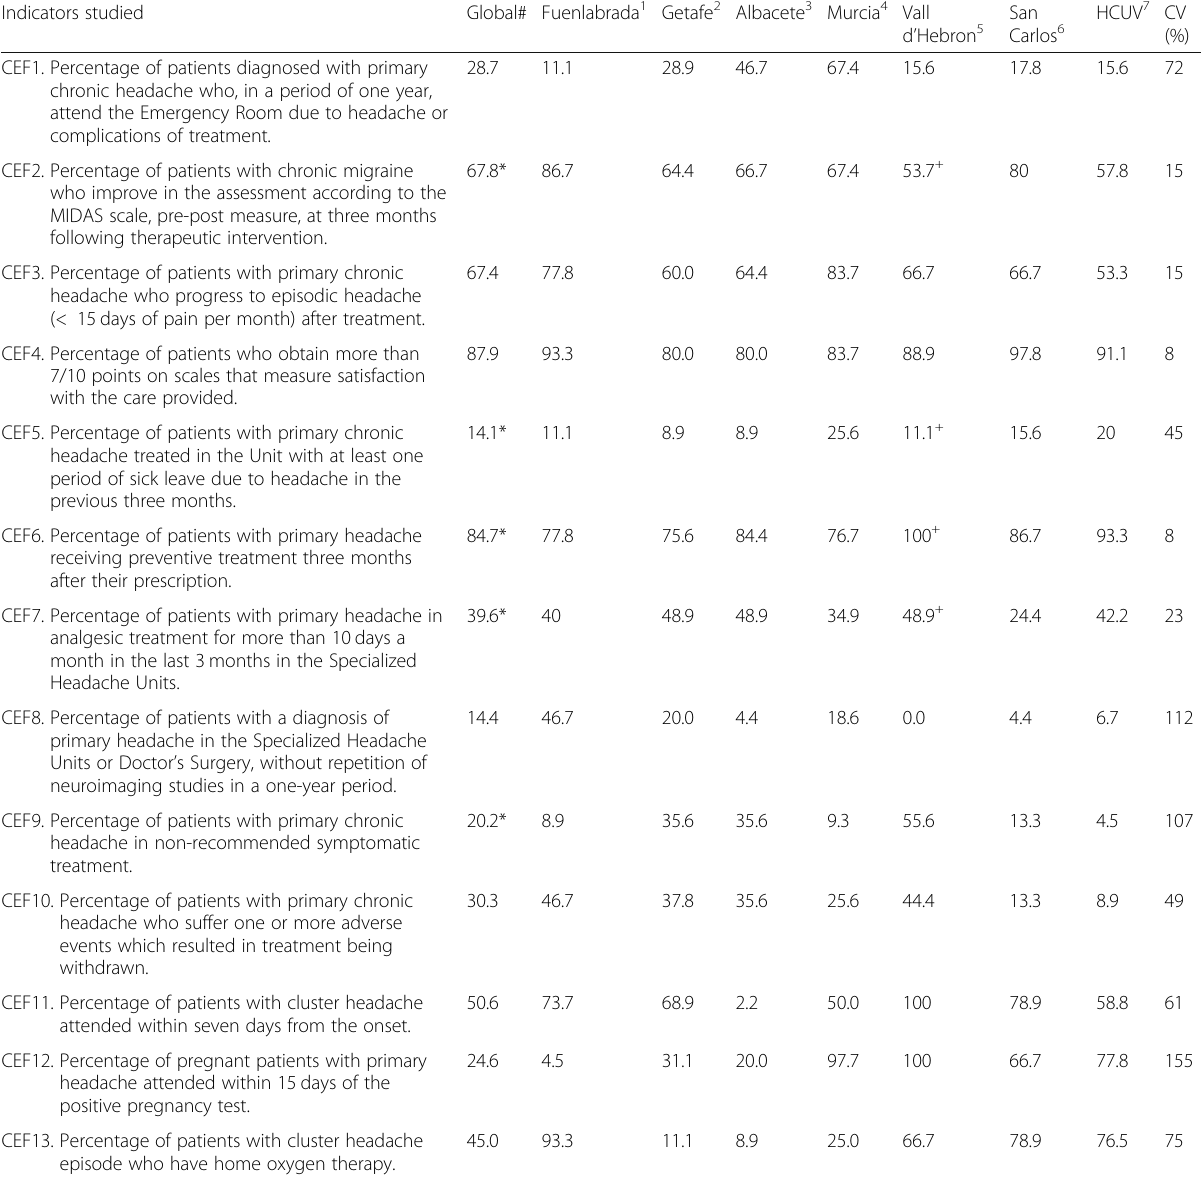
Table 3 Results in the indicators analyzed in each of the participating Specialized Headache Units Indicators studied CEF1. Percentage of patients diagnosed with primary chronic headache who, in a period of one year, attend the Emergency Room due to headache or complications of treatment. CEF2. Percentage of patients with chronic migraine who improve in the assessment according to the MIDAS scale, pre-post measure, at three months following therapeutic intervention. CEF3. Percentage of patients with primary chronic headache who progress to episodic headache (< 15 days of pain per month) after treatment. CEF4. Percentage of patients who obtain more than 7/10 points on scales that measure satisfaction with the care provided. CEF5. Percentage of patients with primary chronic headache treated in the Unit with at least one period of sick leave due to headache in the previous three months. CEF6. Percentage of patients with primary headache receiving preventive treatment three months after their prescription. CEF7. Percentage of patients with primary headache in analgesic treatment for more than 10 days a month in the last 3 months in the Specialized Headache Units. CEF8. Percentage of patients with a diagnosis of primary headache in the Specialized Headache Units or Doctor ’ s Surgery, without repetition of neuroimaging studies in a one-year period. CEF9. Percentage of patients with primary chronic headache in non-recommended symptomatic treatment. CEF10. Percentage of patients with primary chronic headache who suffer one or more adverse events which resulted in treatment being withdrawn. CEF11. Percentage of patients with cluster headache attended within seven days from the onset. CEF12. Percentage of pregnant patients with primary headache attended within 15 days of the positive pregnancy test. CEF13. Percentage of patients with cluster headache episode who have home oxygen